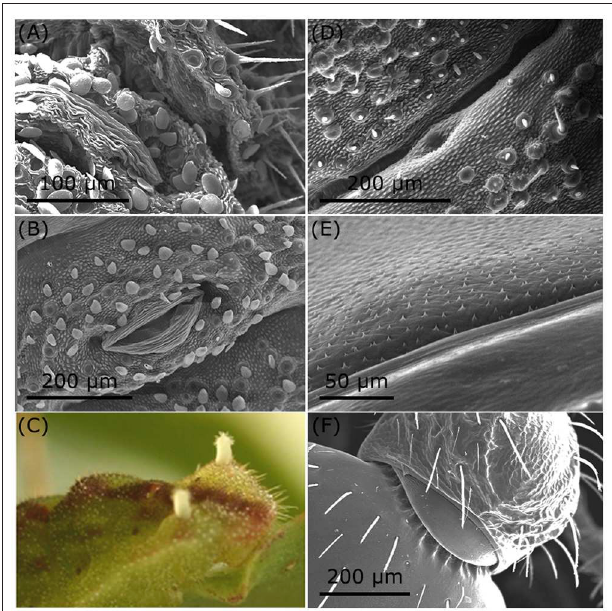
FIGURE 2 | Morphology of organs producing chemicals and vibroacoustic signals in myrmecophiles and their host ants. (A) Pore cupola organs (PCOs) and (B) dorsal nectary organ (DNO) of fourth-instar Maculinea rebeli caterpillars; (C) tentacular organs of fourth-stage Scolitantides orion caterpillar; (D) the possible sound-producing organ of M. rebeli caterpillars; (E) stridulatory organ of M. rebeli pupa, formed by a stridulatory plate ( pars stridens ) located on the sixth abdominal segment and a file ( plectrum ) in the fifth abdominal segment. (F) Stridulatory organ of Myrmica sabuleti .